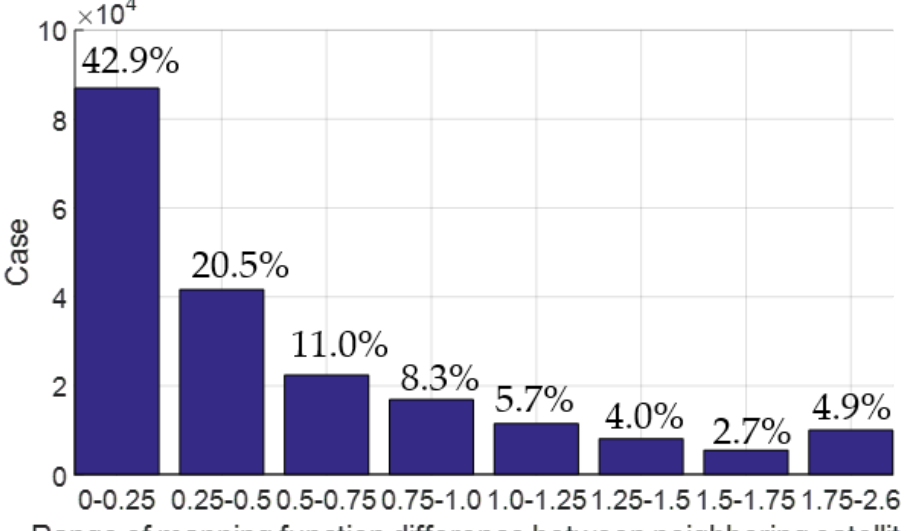
Figure 23. Statistics of mapping functions after differencing between satellites with closest mapping functions (GPS).